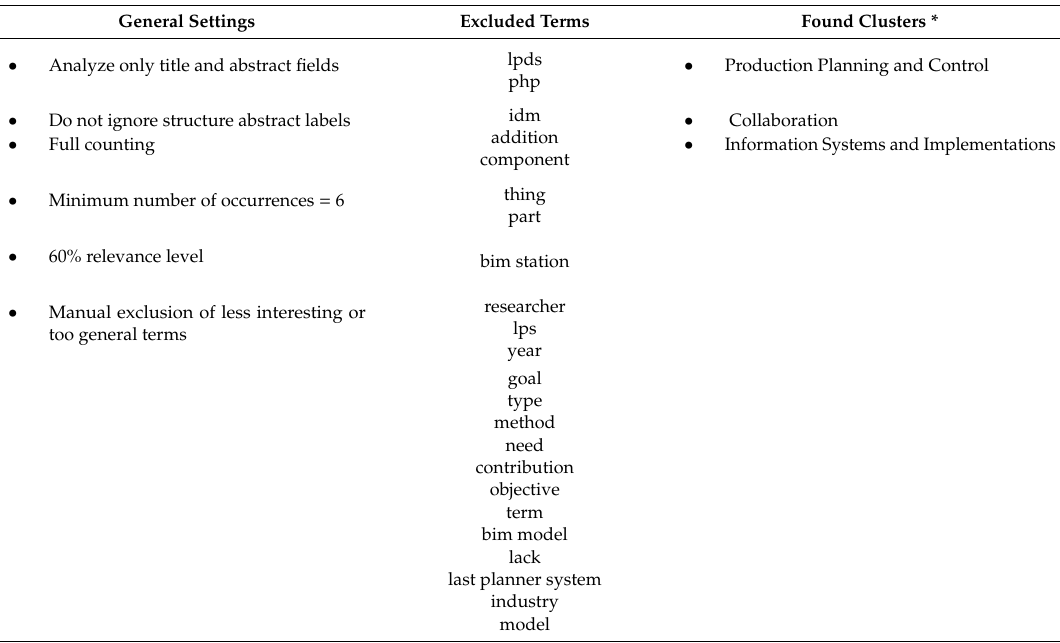
Table 4. VOSViewer settings and found clusters.